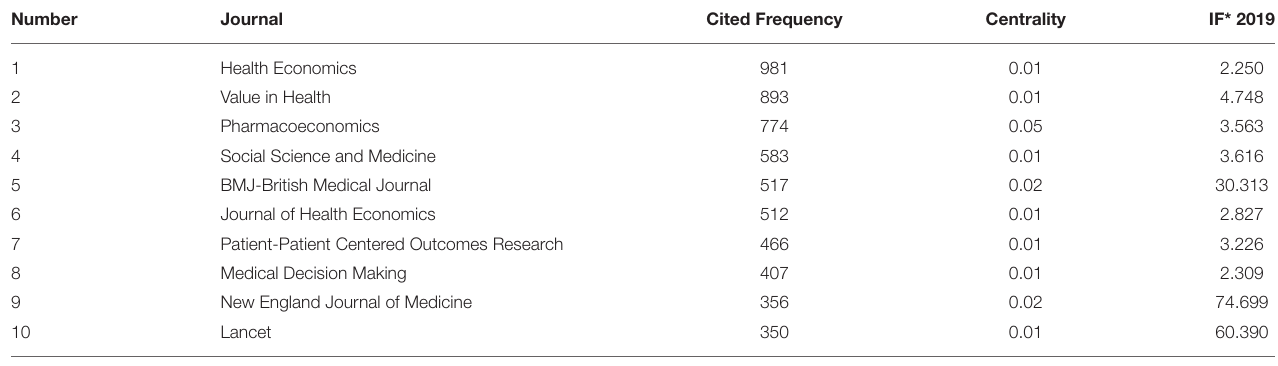
TABLE 3 | The top 10 cited journals.